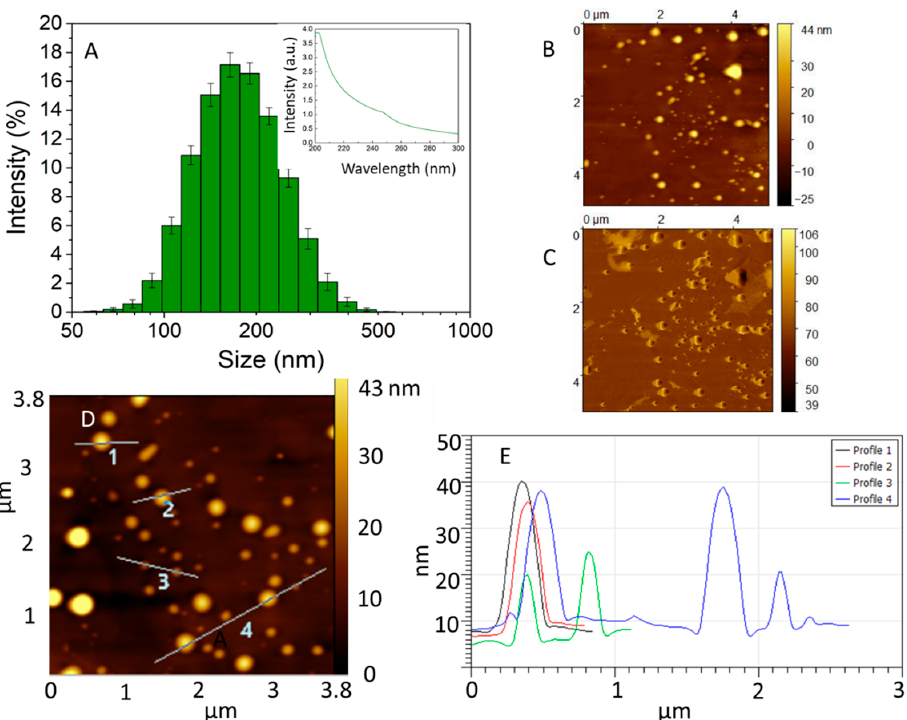
Figure 2. ( A ) Dynamic light scattering (DLS) data of dispersions of 1 mg/mL propolis showing the main NP population between 70–300 nm. Inset: UV-vis spectra of the propolis ethanolic extract showing an absorption band at 250 nm. AFM image of ( B ) the topography and ( C ) the phase of NPs adsorbed on highly pyrolytic oriented graphite. ( D ) AFM topography image showing line profiles. ( E ) Cross-section height derived from the line profiles shown in ( D ); nanoparticles between 3 to 40 nm height were imaged.